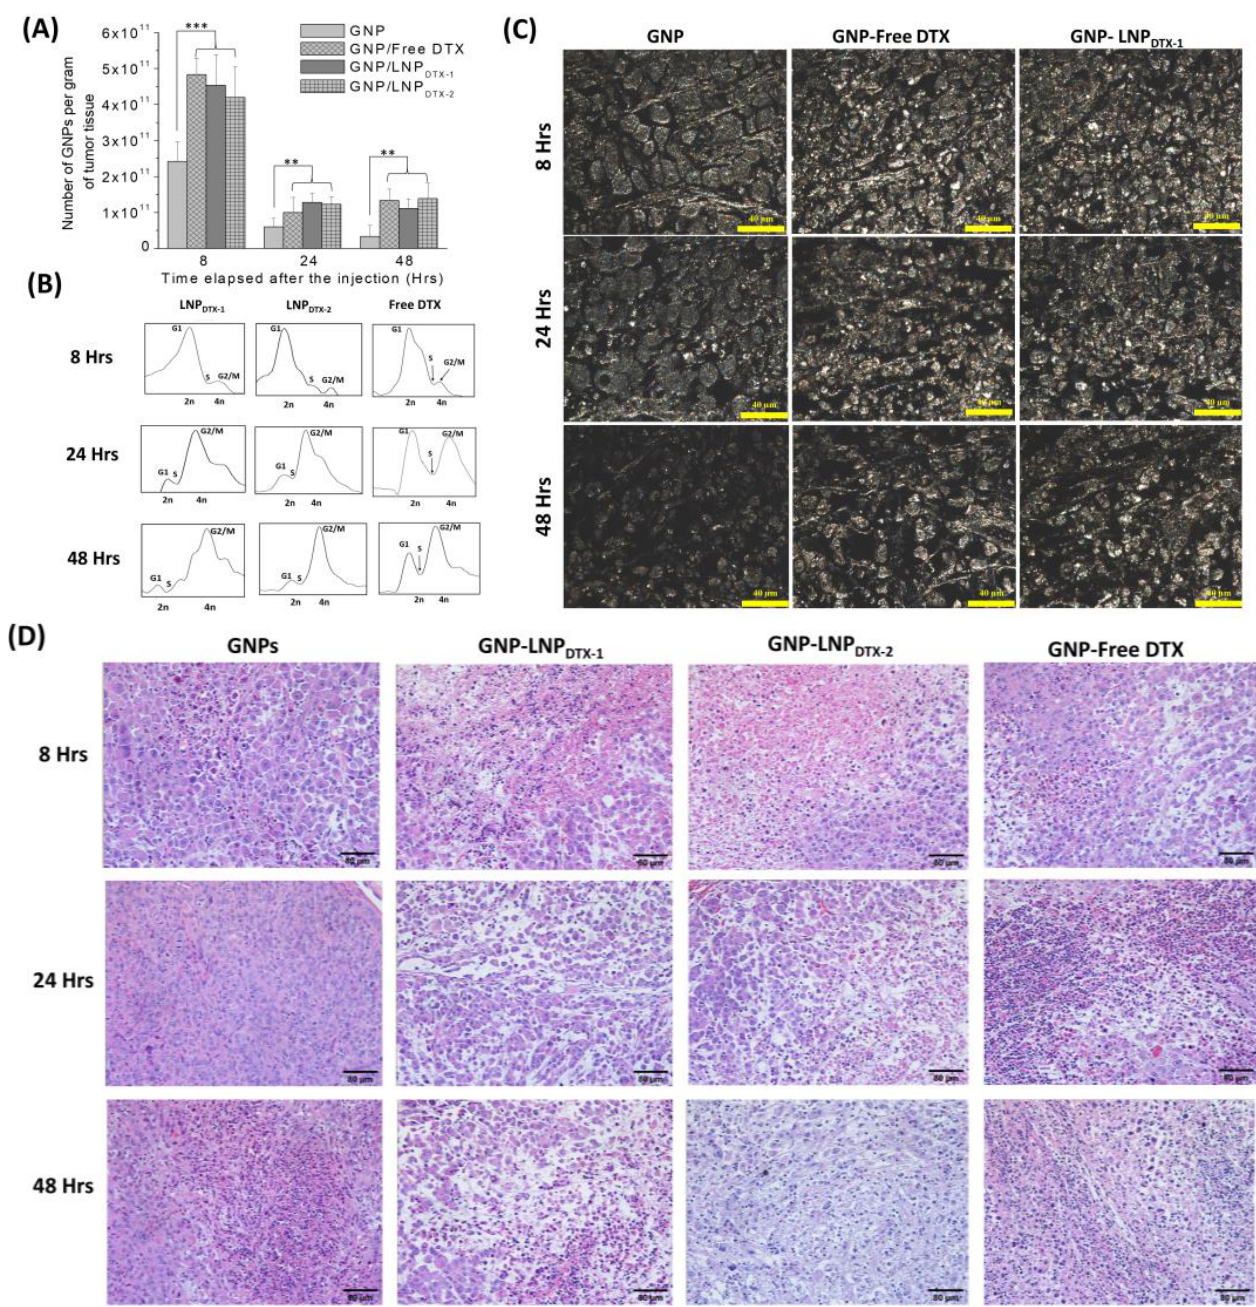
Figure 4. Effects of docetaxel (DTX) vs. LNP DTX-P on in vivo tumour tissues. ( A ) Amounts of gold nanoparticles (GNPs) per gram of tumour tissue in untreated tissues, tissues treated with free DTX, tissues treated with LNP DTX-1 , and tissues treated with LNP DTX-2 over time. ** indicates p < 0.01, *** indicates p < 0.001. ( B ) Cell cycle assay for untreated tumour tissue, tissue treated with free DTX, tissue treated with LNP DTX-1 , and tissue treated with LNP DTX-2 over time. ( C ) Darkfield images of 4 µm sections of untreated tumour tissues, tissues treated with free DTX, and tissues treated with LNP DTX-1 . Scale bar: 40 µm. ( D ) Treatment of MIA PaCa-2 subcutaneous tumour with free docetaxel (DTX) vs. LNP DTX-P . Hematoxylin and eosin stained sections of tumour tissues 0 h, 24 h, and 48 h after dosing with the drugs and GNPs. Scale bar: 80 µm.